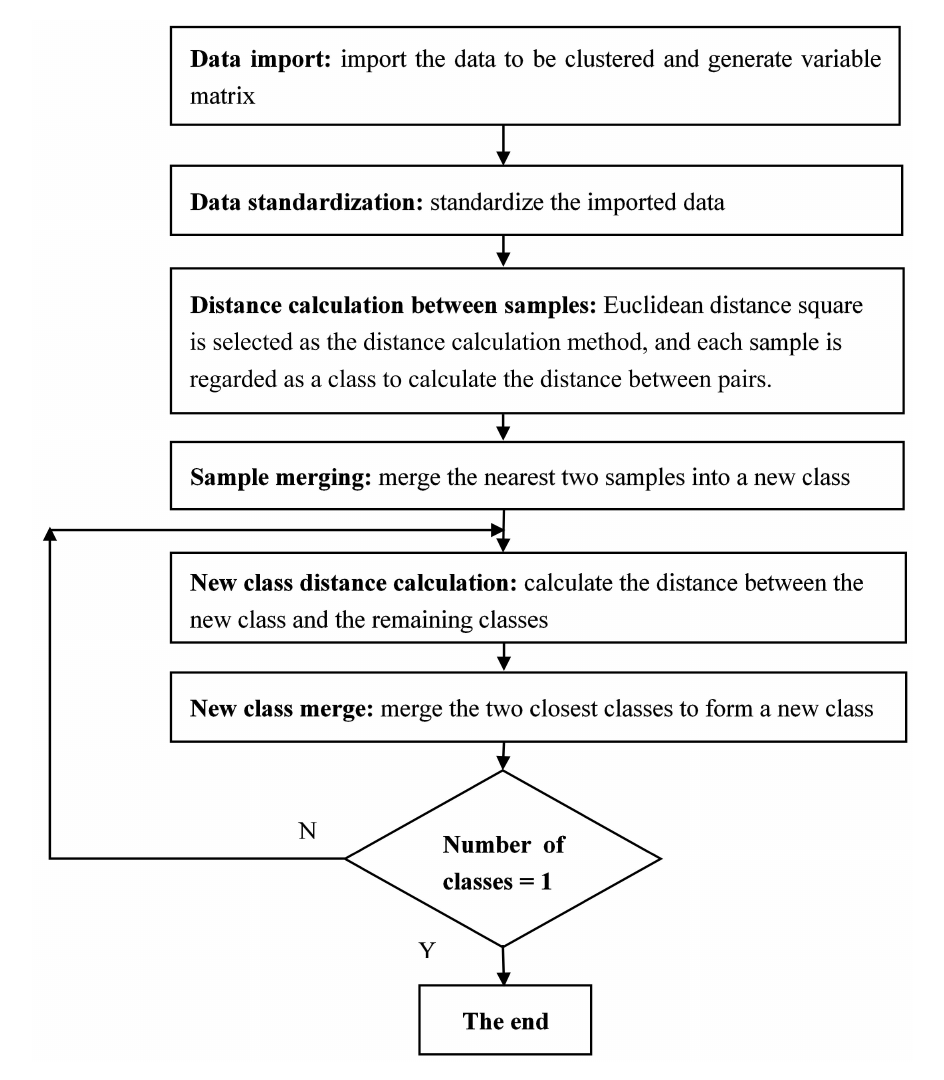
Figure 6. Processes of the Hierarchical clustering method. Table 3. Land consolidation zoning classification in Hubei province based on Hierarchical clustering